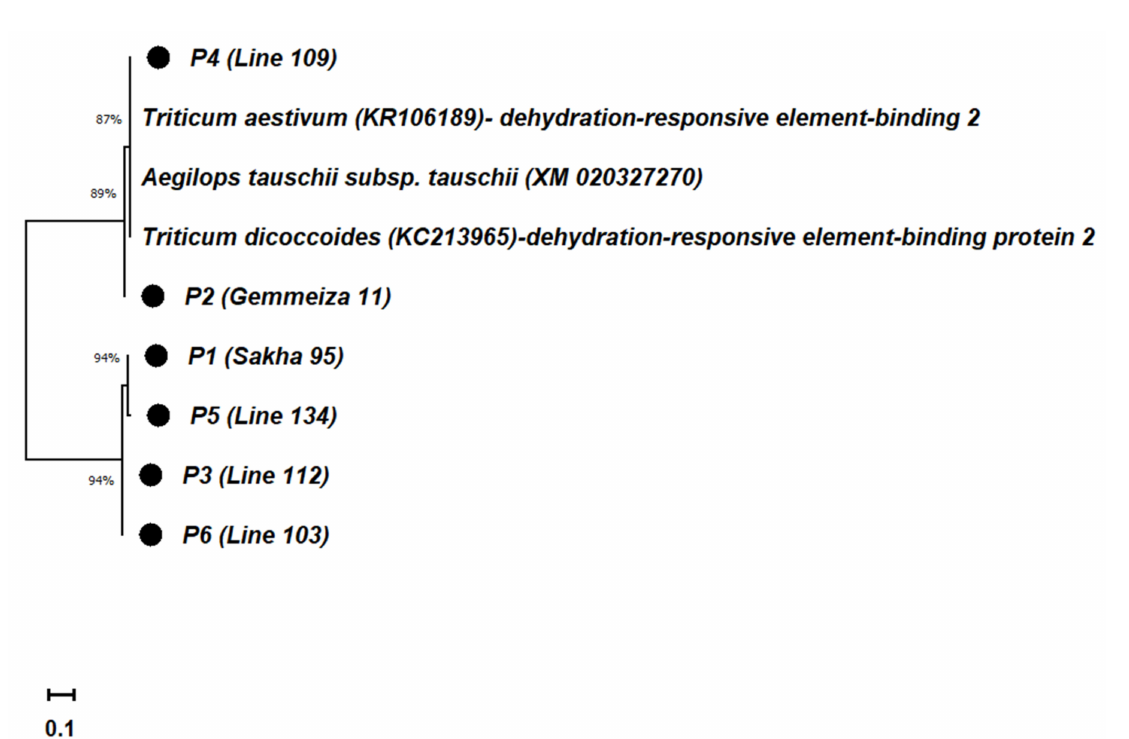
Figure 8. Constructed phylogenetic tree based on the dehydrin gene sequence. The tree contains two clades, the first one displayed heat-tolerant, and the second clade contains the sensitive ones.